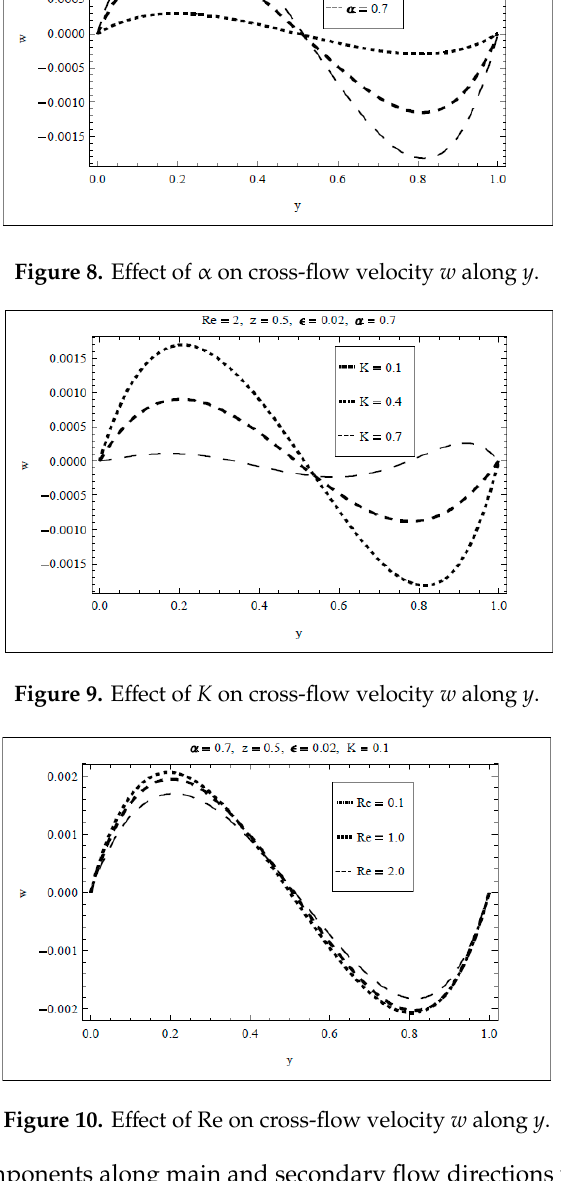
Figure 11. Effect of α on F 1 along Re at K = 0.1.